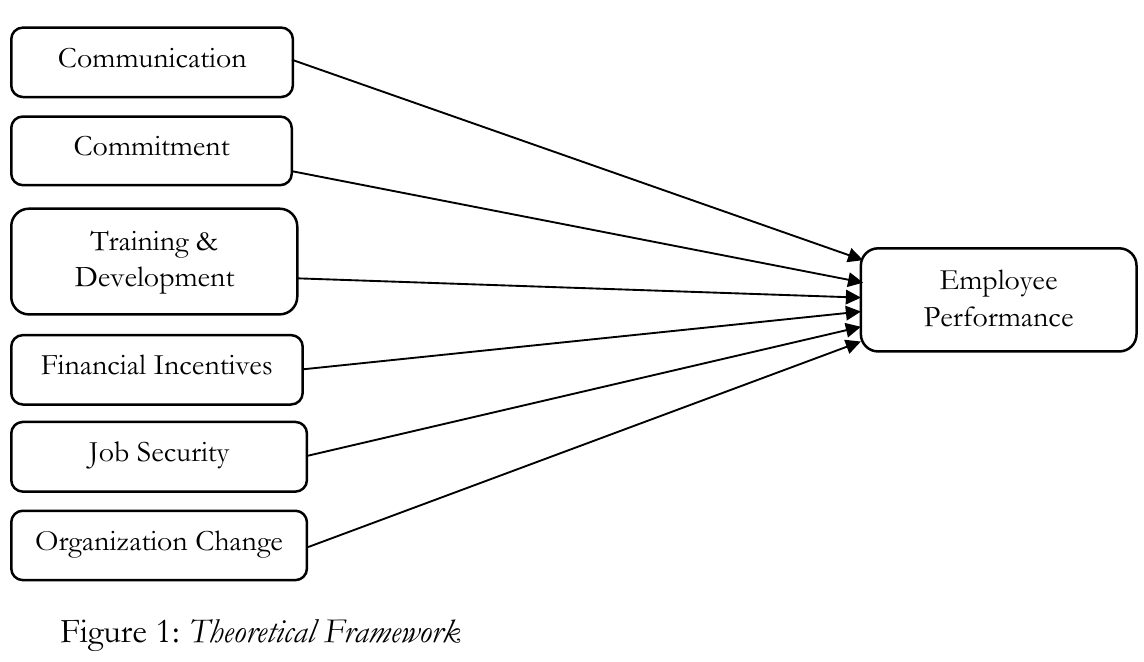
Figure 1: Theoretical